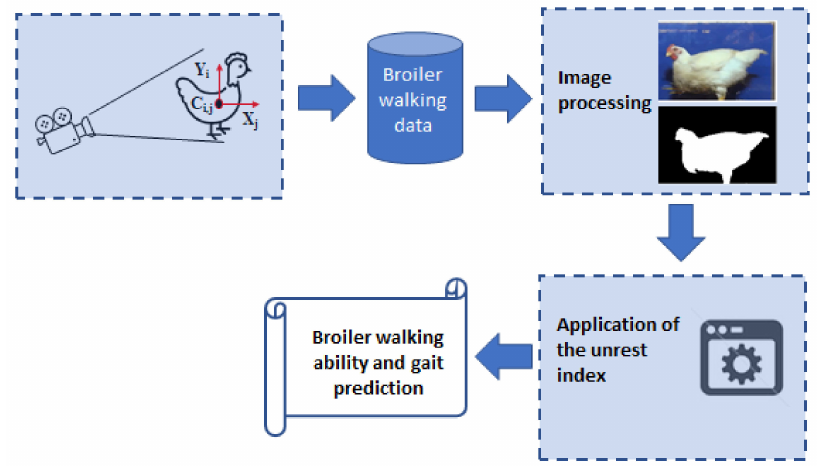
Figure 1. Schematic of the study to predict broiler walking